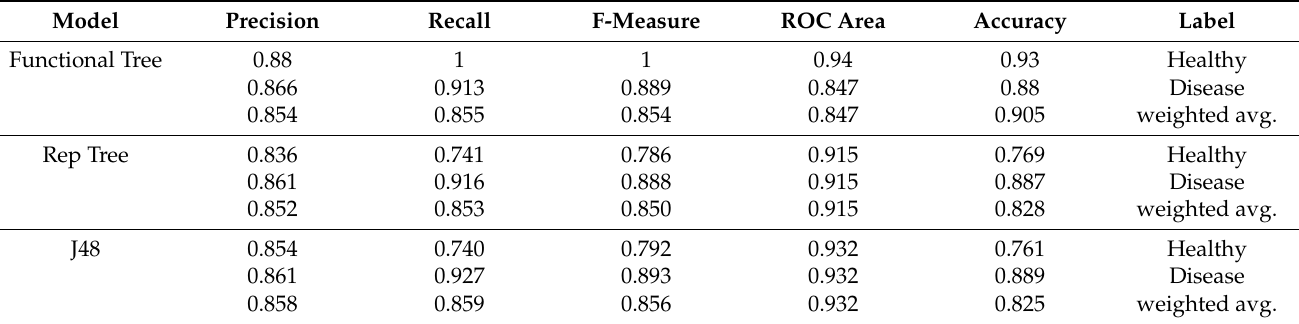
Table 3. Experimental analysis results.